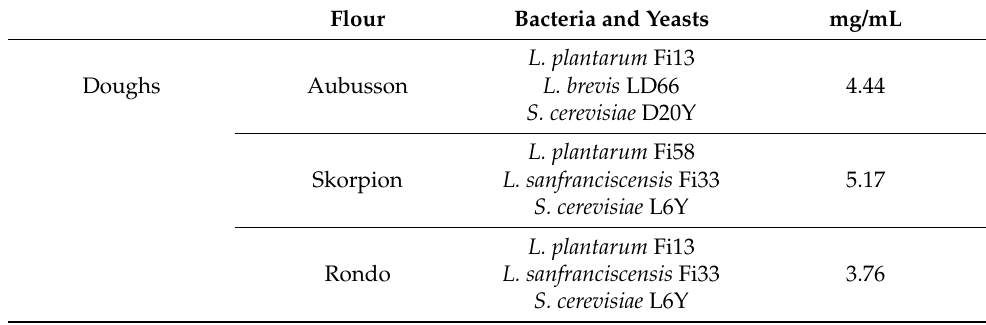
Table 3. LMW peptides from doughs and breads: flours, microorganism used for fermentation, and peptide concentration. Protein was determined by the BCA method and expressed in